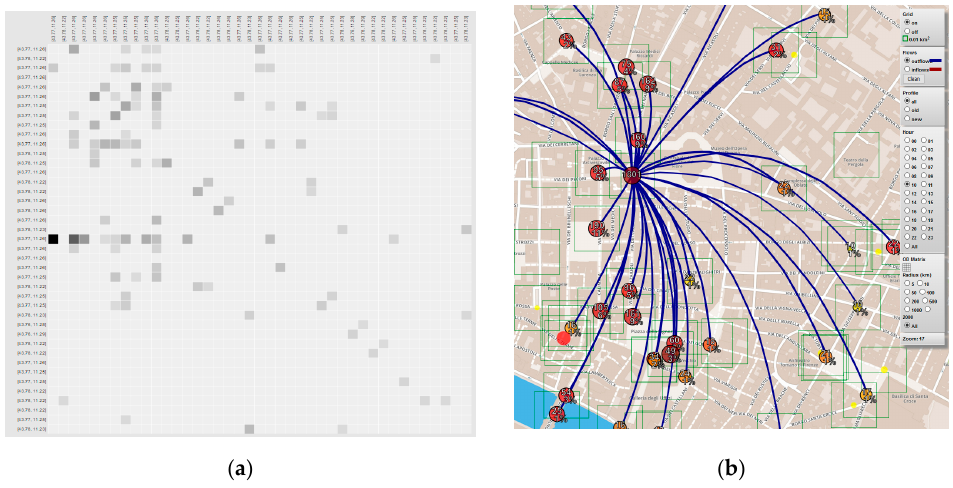
Figure 10. OD matrix for Florence downtown. In the OD matrix can be provided as: ( a ) classical view; ( b ) advanced interactive view where is possible to visualize inflow, outflow, time slot selec- tion, user kind, and so forth.